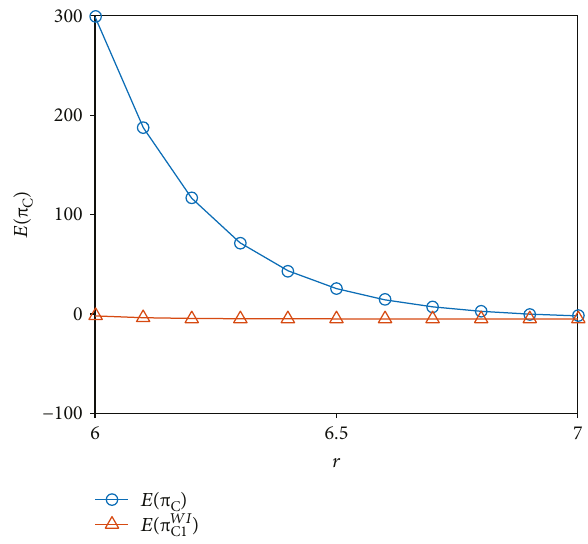
Figure 6: Change of the company ’ s performance before and after the implementation of WI , φ .